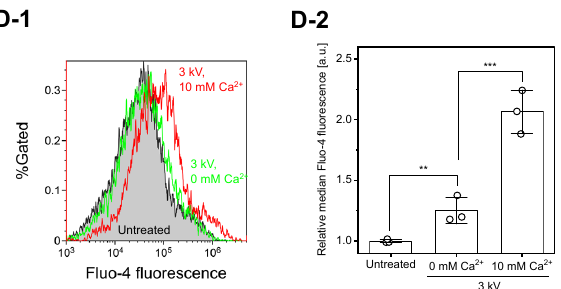
Figure 2. Measurement of intracellular calcium ion. ( A-1 – A-6 ) Intensity of fluorescence of Fluo-4 and 7-AAD was measured and plotted using a log scale. The percentages of 7-AAD-positive (dead) cells (Q1 + Q2) and Fluo-4-positive cells (Q2 + Q4) are shown. ( B , C ) The population of Fluo-4- positive cells and cell viability after short-circuiting using HEPES-saline ( B ) or HEPES-sucrose ( C ), as determined using flow cytometry. Data are expressed as the mean ± standard deviation (SD) of three independent measurements. Statistical significance was determined using one-way ANOVA followed by Tukey’s multiple comparison tests, ∗ p < 0.05, ∗∗ p < 0.01, and ∗∗∗ p < 0.001. ( D ) Changes in Fluo-4 fluorescence intensity after short-circuiting using HEPES-saline. Representative flow cytometry histograms ( D-1 ) and relative median Fluo-4 fluorescence intensity ( D-2 ) are shown. Data are expressed as the mean ± SD of triplicate measurements. Statistical significance was determined using one-way ANOVA followed by Tukey’s multiple comparison tests, ∗∗ p < 0.01 and ∗∗∗ p <